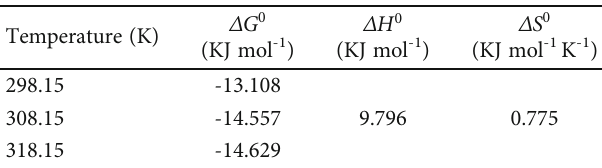
Table 6: Values of thermodynamic parameters for CIP adsorption onto MBC.